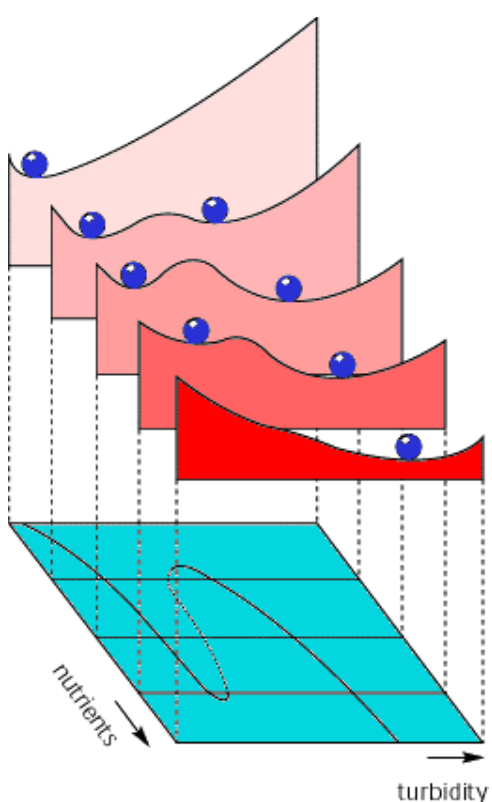
FIGURE 4. ‘Marble-in-a-cup’ representation of the stability properties of lakes at five different levels of nutrient loading. (See